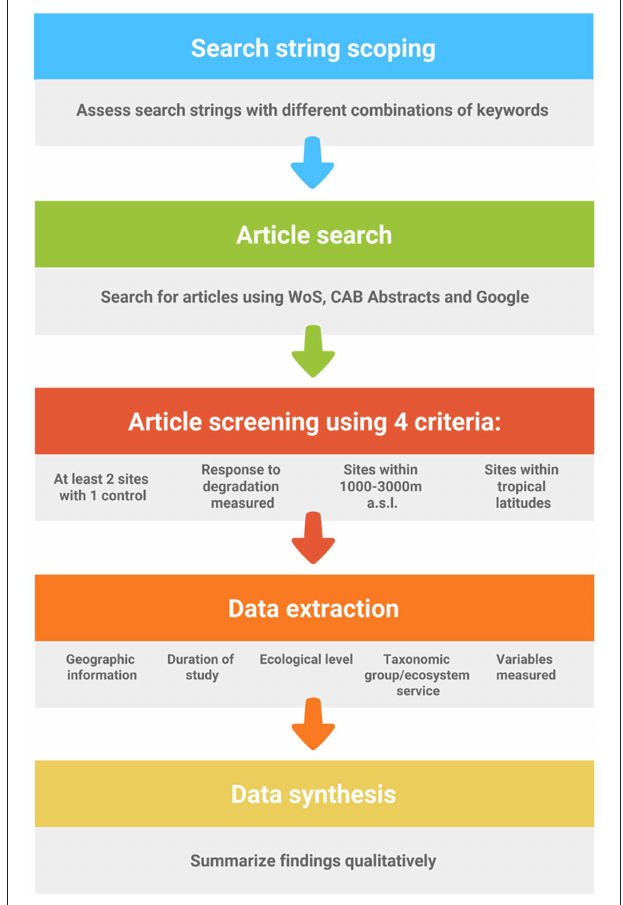
FIGURE 1 | Flow diagram of the systematic mapping protocol. WoS, Web of Science.